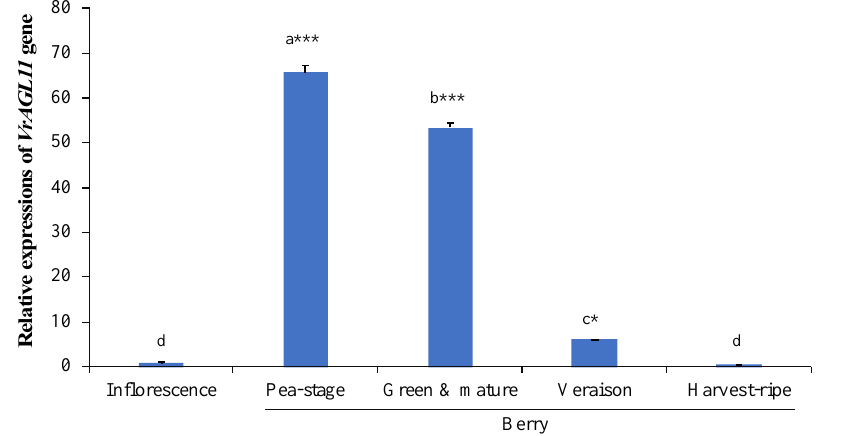
Figure 2. The relative expressions of muscadine grape AGL11 ( VroAGL11 ) gene in leaf, inflorescence and berry at different developmental stages (pea-size, green & mature, veraison and harvest-ripe) of muscadine grape cultivar, Noble. The vertical bars represent the standard error of three biological replicates. Bars with different letters differ significantly according to Tukey HSD post-hoc test (*** p <0.001, * p < 0.05).